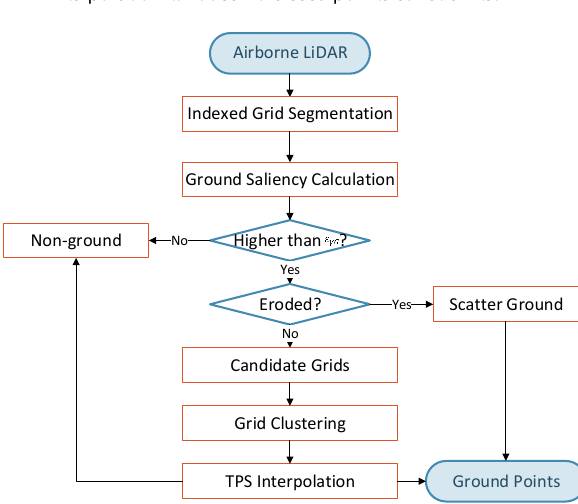
Figure 1. The workflow of this paper